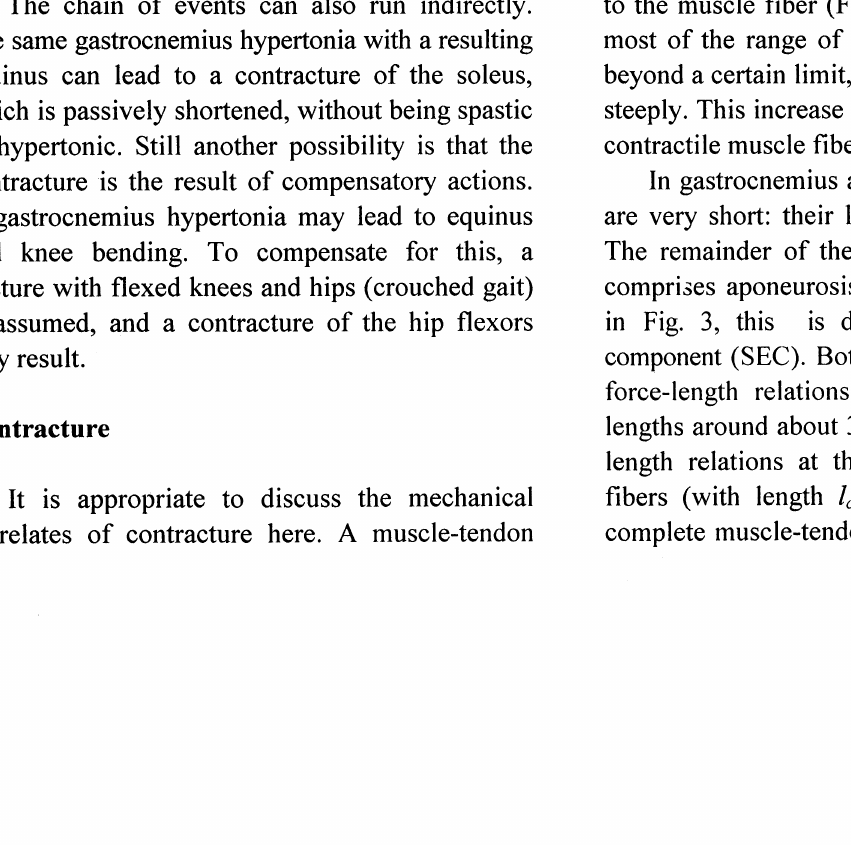
leads to a state of continuous shortening of the muscle. This active shortening can then result in a permanent length adaptation, a contracture. When, for example, the gastrocnemius generates so much force that the antagonist tibialis anterior cannot adequately counteract, the ankle will remain continuously in an equinus position. This position can become fixed into a